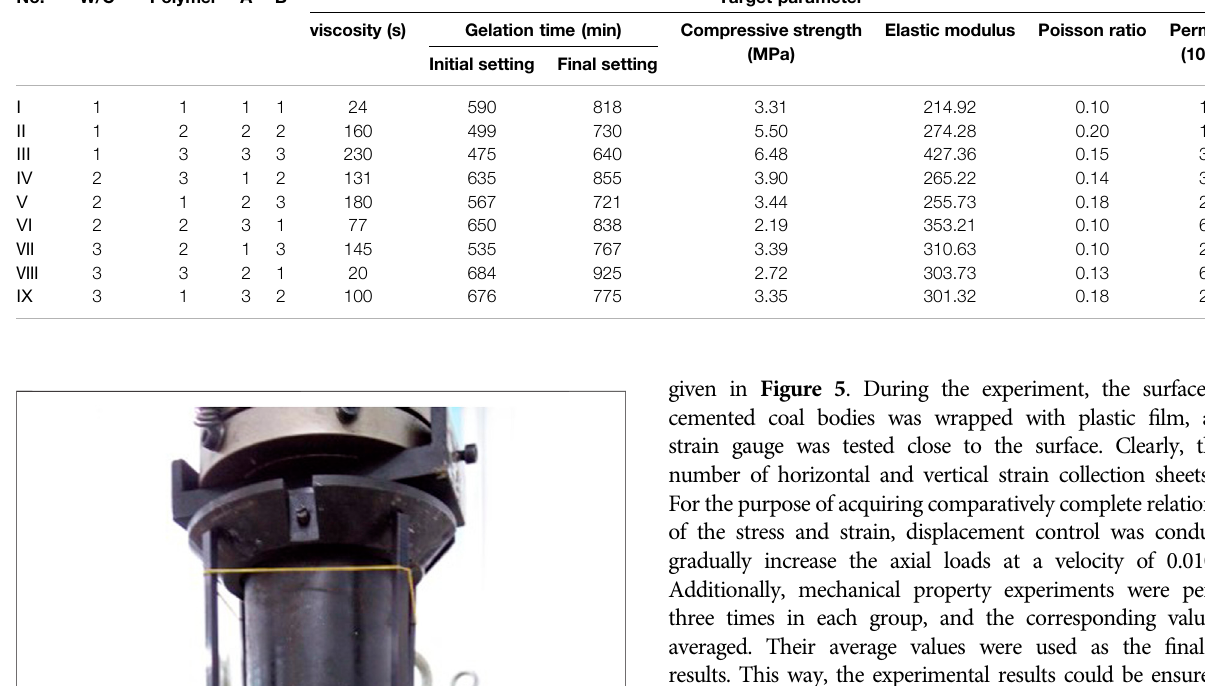
TABLE 2 | Orthogonal experimental design and experimental results of target parameters of PMCC sealing materials and cemented coal bodies. No.